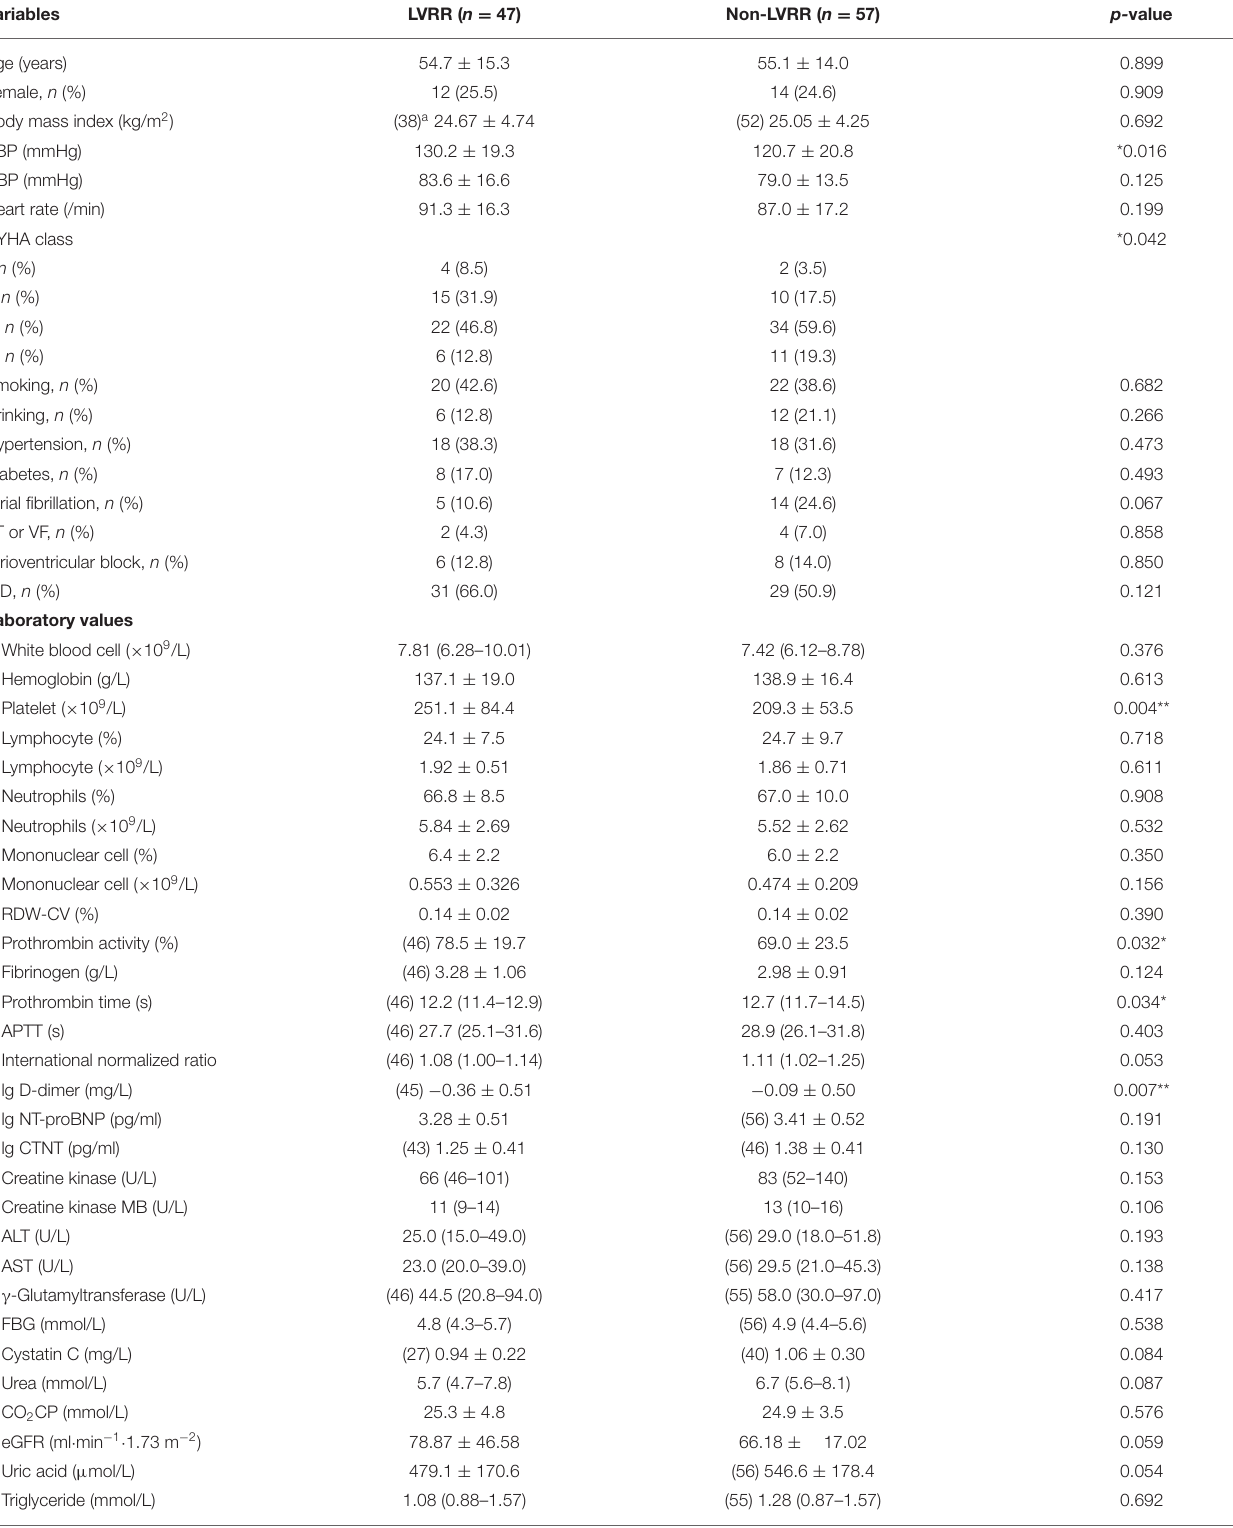
TABLE 1 | Characteristics of patients grouped by left ventricular reverse remodeling.